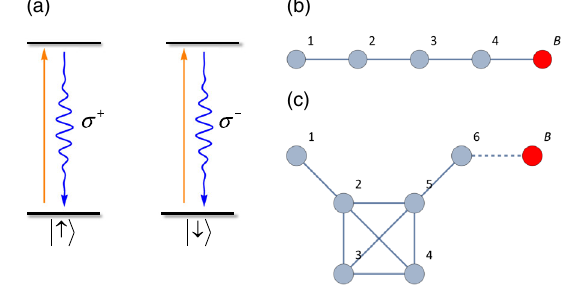
FIG. 2. (a) Level structure required for the emitter to emit entangled photons. Each of two ground states couples to its own excited state. Cross transitions are forbidden by selection rules. (b) Linear photonic cluster state. Photons are blue circles, while the red circle is the emitter. Each line represents entanglement between the qubits it connects. (c) Partial N ¼ 4 repeater state.